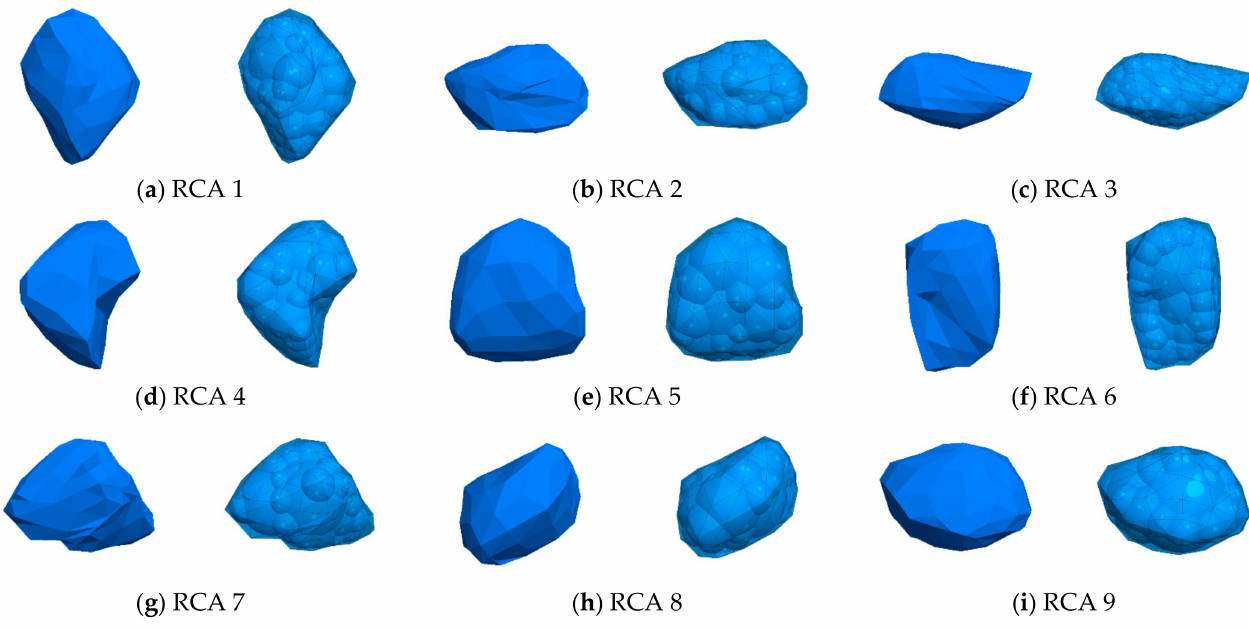
Figure 4. Nine typical RCA